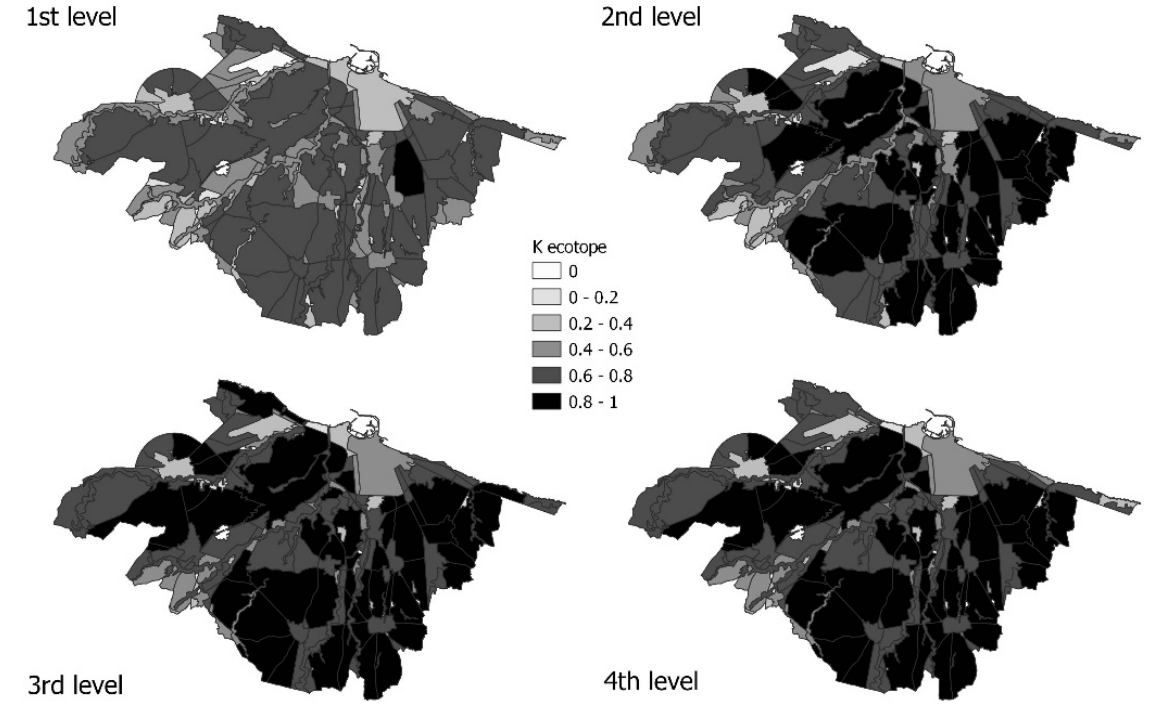
Figure 4. Land cover patch diversity at (Bio-Energy Landscape Units) BELU level displayed by K ecotope. K ecotope is a PANDORA factor related to the perimeters (i.e., ecotone length) of vegetated land cover patches (BTC > 0).